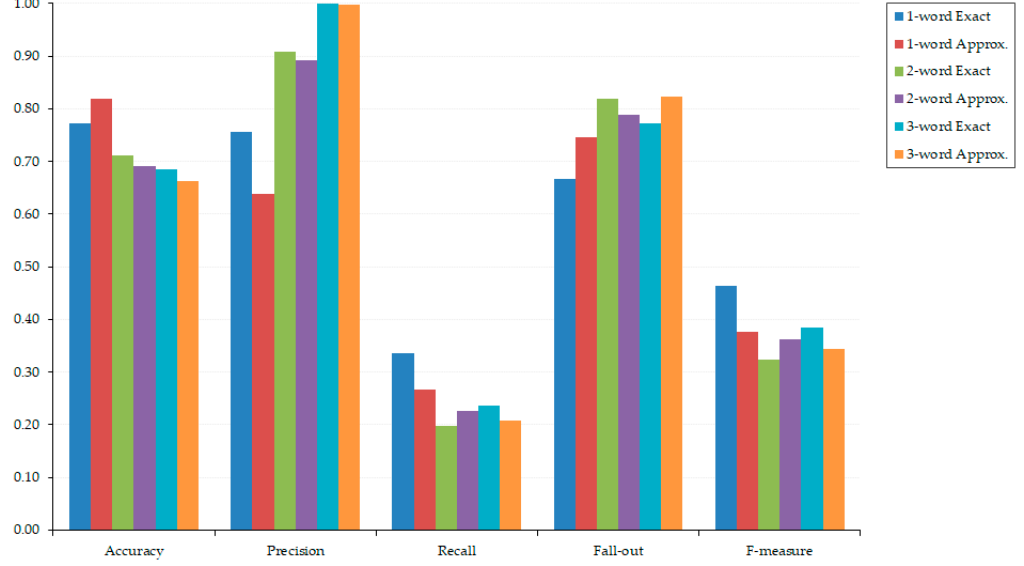
Figure 9. Comparison aggregated performance measures in retrieval optimized for precision. Table 3. Retrieval statistical pair tests for one-way ANOVA ( α = 0.05); significant di ff erences are marked with square symbols ( (cid:4)